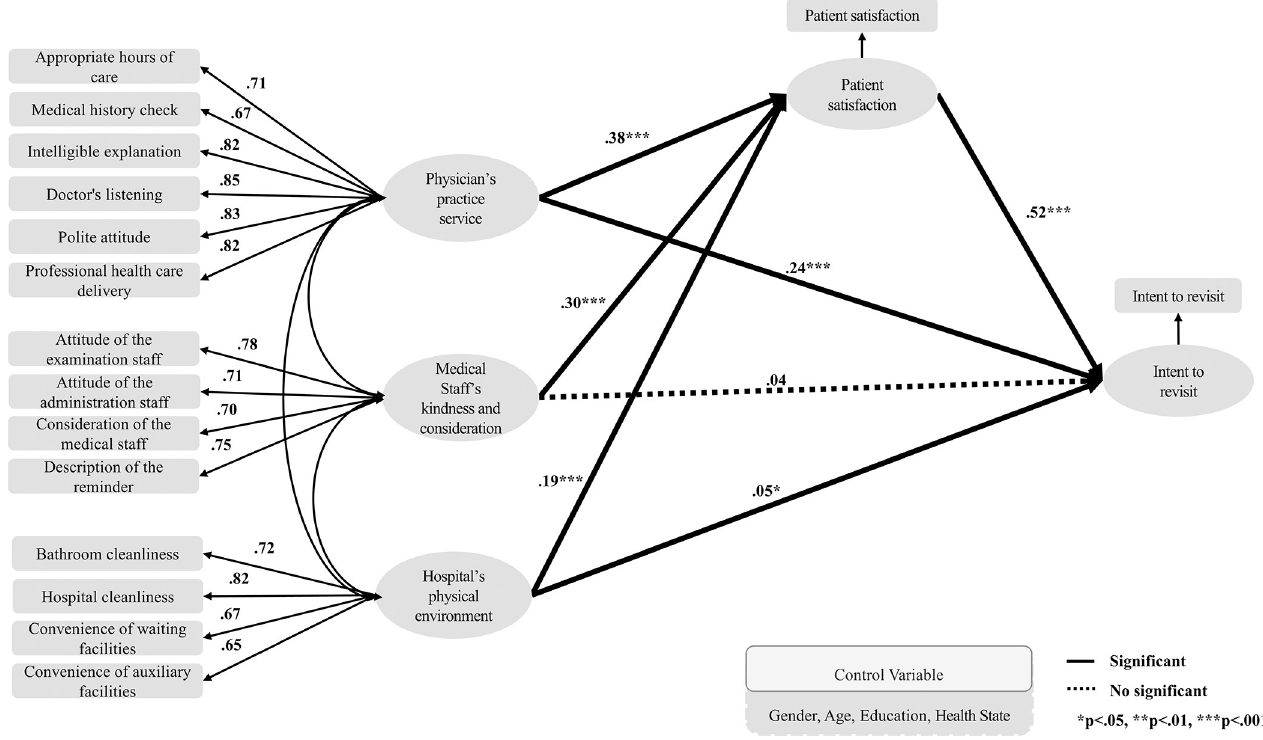
Fig 1. Path diagram for the structural equation model